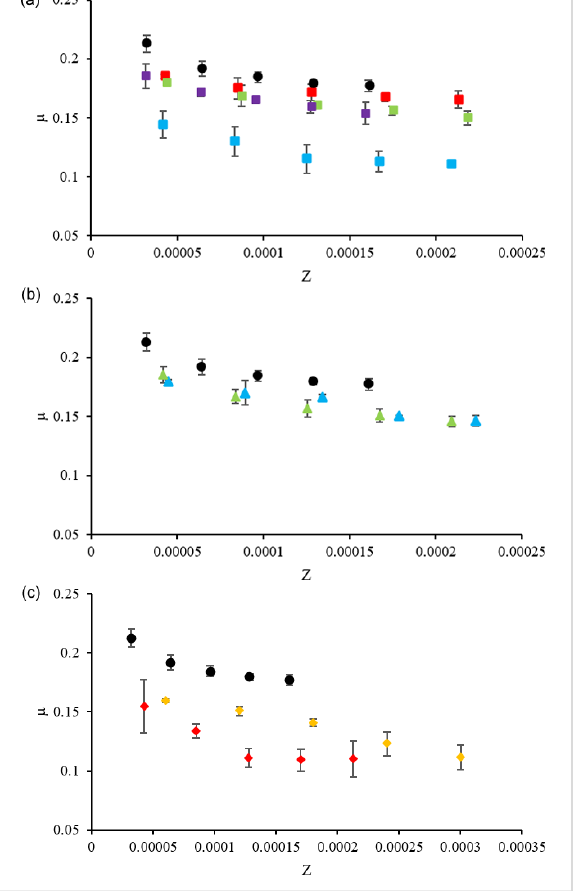
Figure 5: CoF vs Sommerfeld parameter, Z , for (a) TfO-based, (b) DCA-based and (c) EtSO 4 -based ILs mixed with PEG: PEG (black circles), PEG + [EMIM][TfO] (red squares), PEG + [BMIM][TfO] (blue squares), PEG + [C 2 OHMIM][TfO] (green squares), PEG + [AMIM][TfO] (purple squares), PEG + [BMIM][DCA] (blue triangles), PEG + [C 2 OHMIM][DCA] (green triangles), PEG + [EMIM][EtSO 4 ] (red